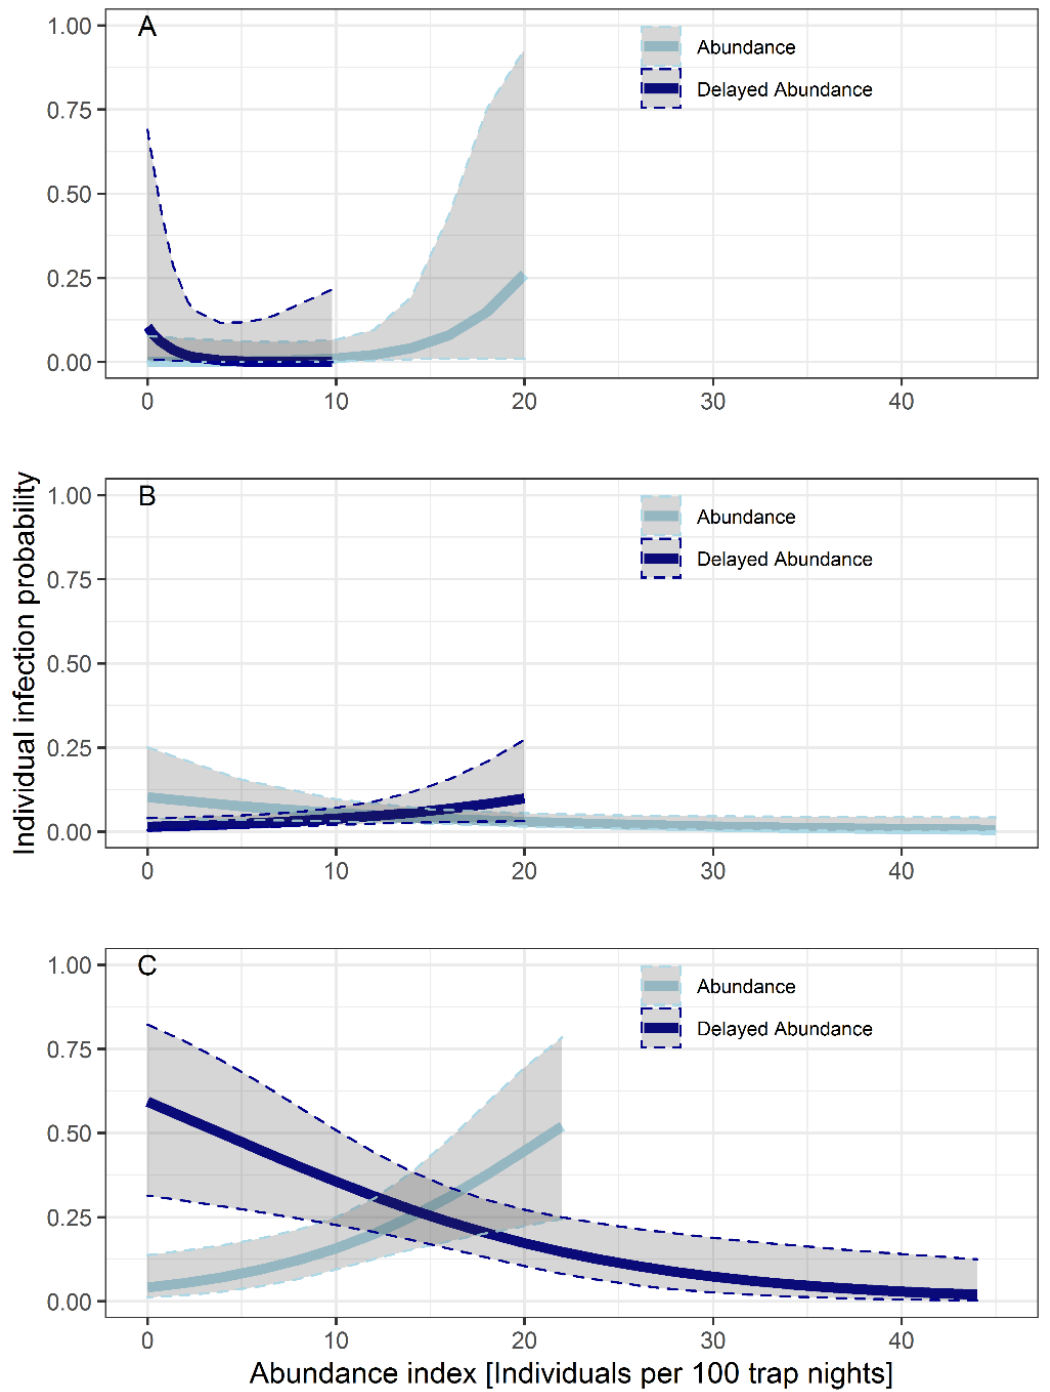
Figure 4. Potential influence of abundance and delayed abundance in ( A ) spring, ( B ) summer and ( C ) autumn in the year 2019 on individual infection probability (Abundance = bank vole abundance of the present season, Delayed Abundance = bank vole abundance of the previous season). Results are based on lipl32 -qPCR-positive animals. (Years 2018 and 2020 are not shown, because no significant influences were documented). Table 4. Results of generalized linear mixed modelling with binomial error distribution showing the impact of abundance and delayed abundance on individual infection probability for the year 2019.